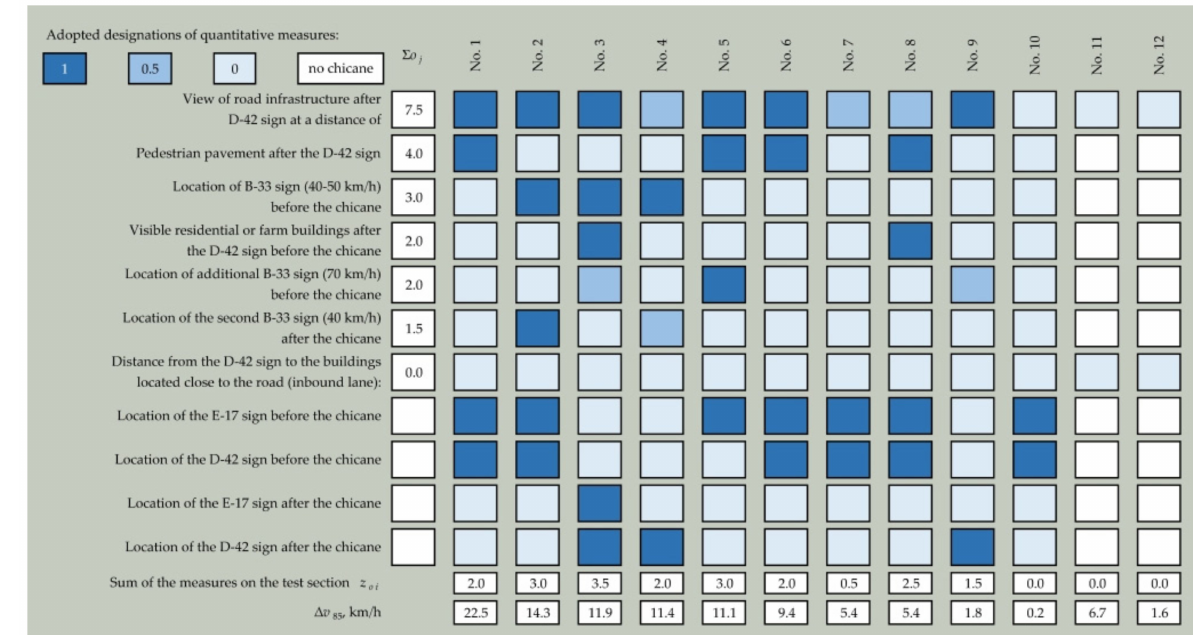
Figure 11. Outcomes of the assessment of the factors associated with the traffic management criterion. Where: o j is a subsequent factor under consideration , Σ o j is the sum of confirmed logical tautologies on the test sections in relation to the considered j -th factor , and z o i is the sum of quantitative measures in all factors on the i -th test